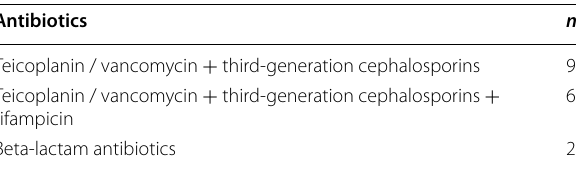
Table 4 Two-weeks after systemic antibiotic therapies in